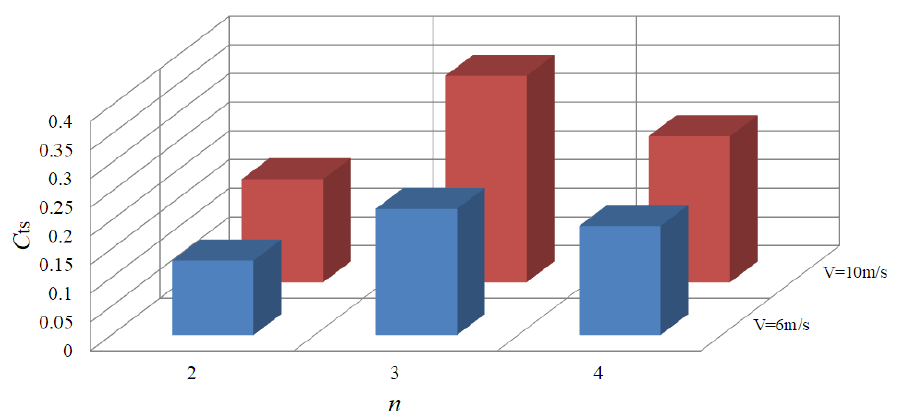
Figure 21. The change in the average increase in the static torque of the three numbers of blades LDCS.